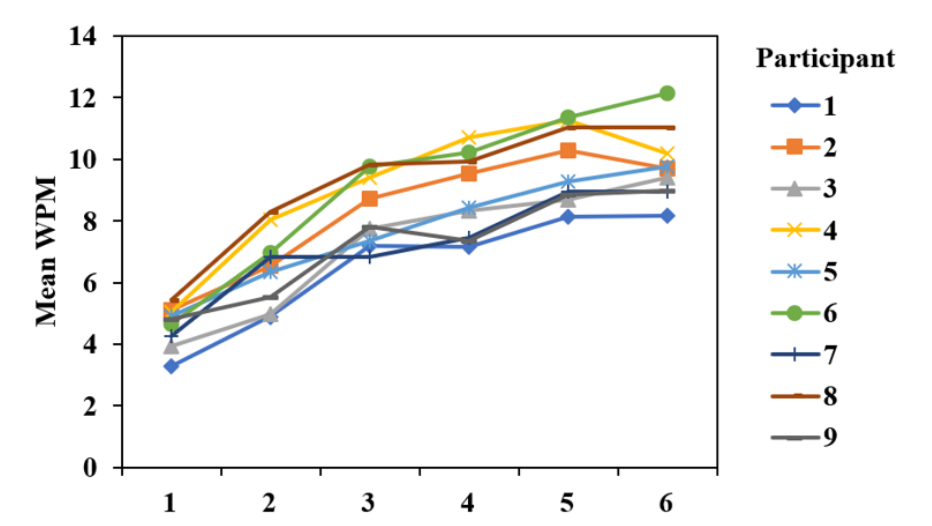
Figure 15. Entry speed of every participant across the 6 blocks.